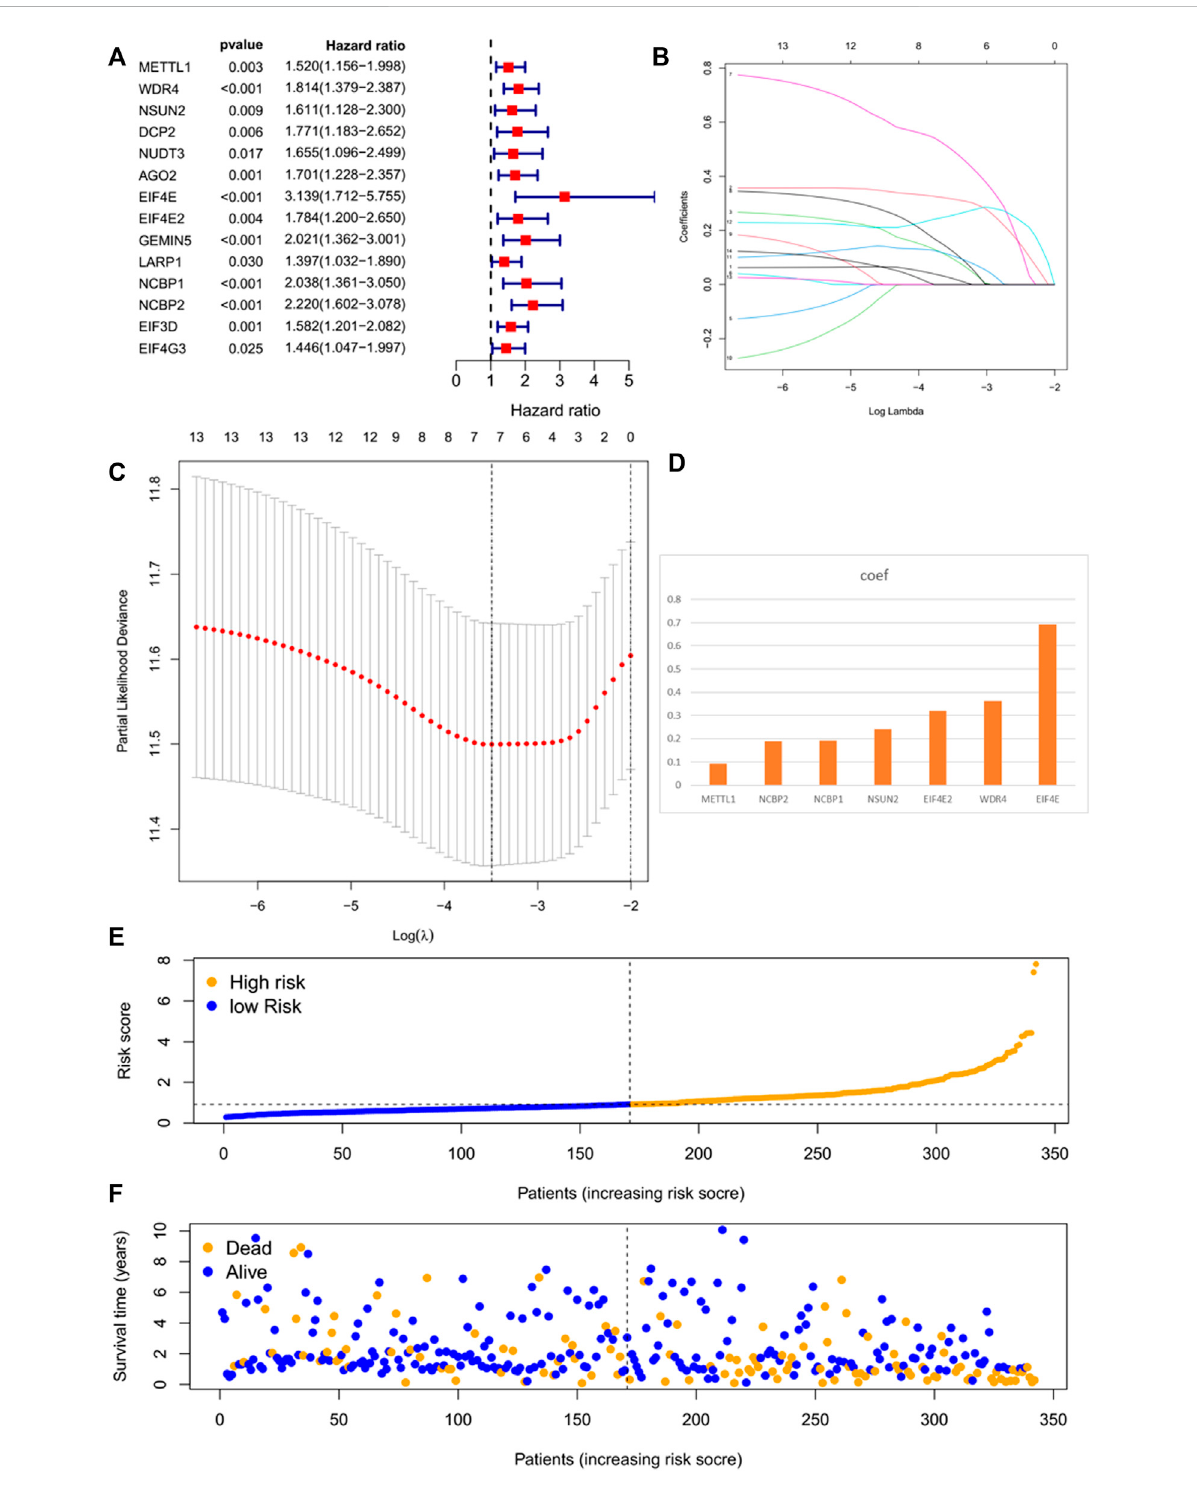
FIGURE 5 The prognostic risk model established on basis of m 7 G RNA modi fi cation regulator genes. (A) Univariate Cox regression analyses of m 7 G RNA methylation regulators. (B – D) The process of constructing signatures applying least absolute shrinkage and selection operator (LASSO) Cox regression. (E) Distribution of risk scores of the patients in the prognostic model. (F) Distributions of survival status of the patients in the prognostic